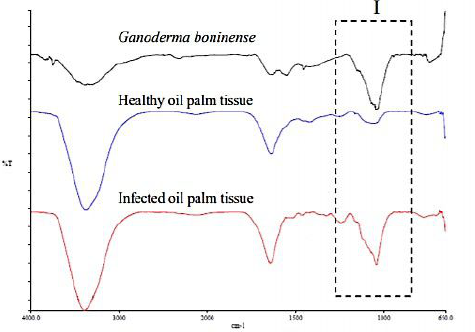
Figure 2. FTIR spectra of G. boninense , healthy oil palm tissue and infected oil palm tissue